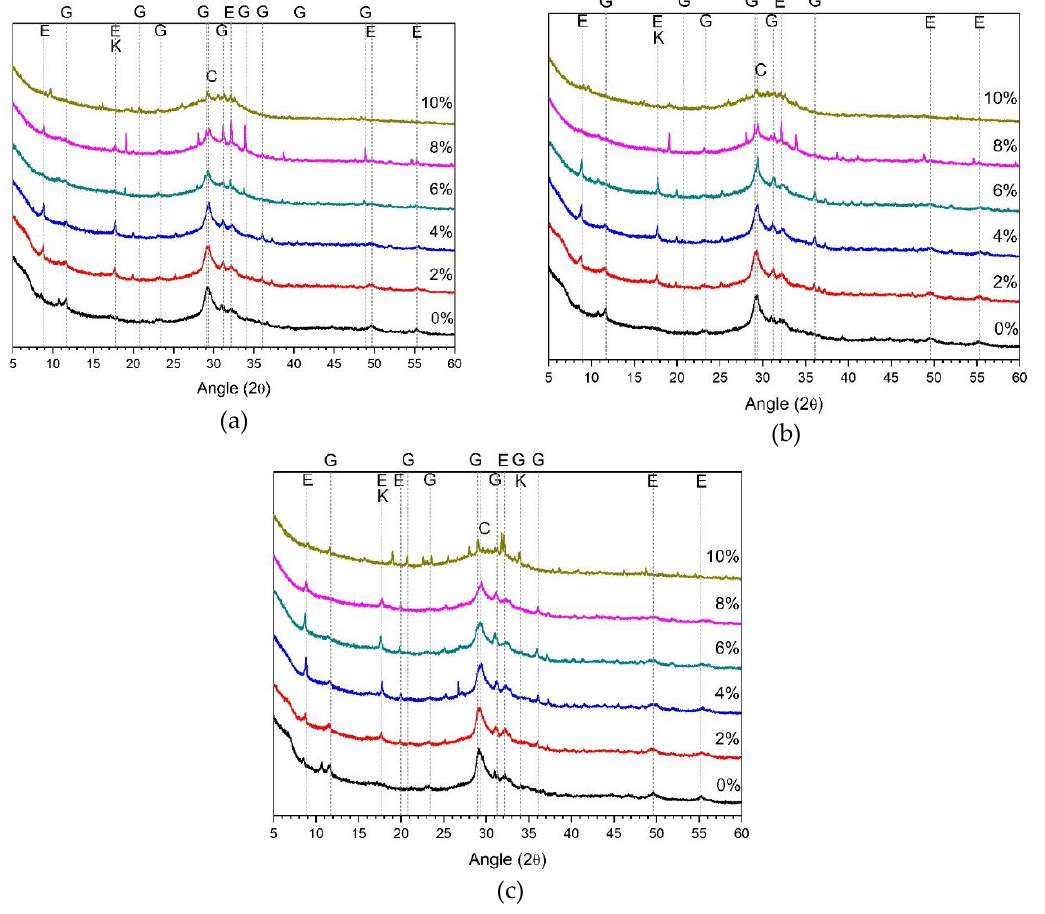
Figure 4. XRD analysis of 5% alkali with ALS at ( a ) day 1, ( b ) day 3, and ( c ) day 28. E: ettringite; G: gypsum; C: C–S–H gel and calcite; K: katoite.